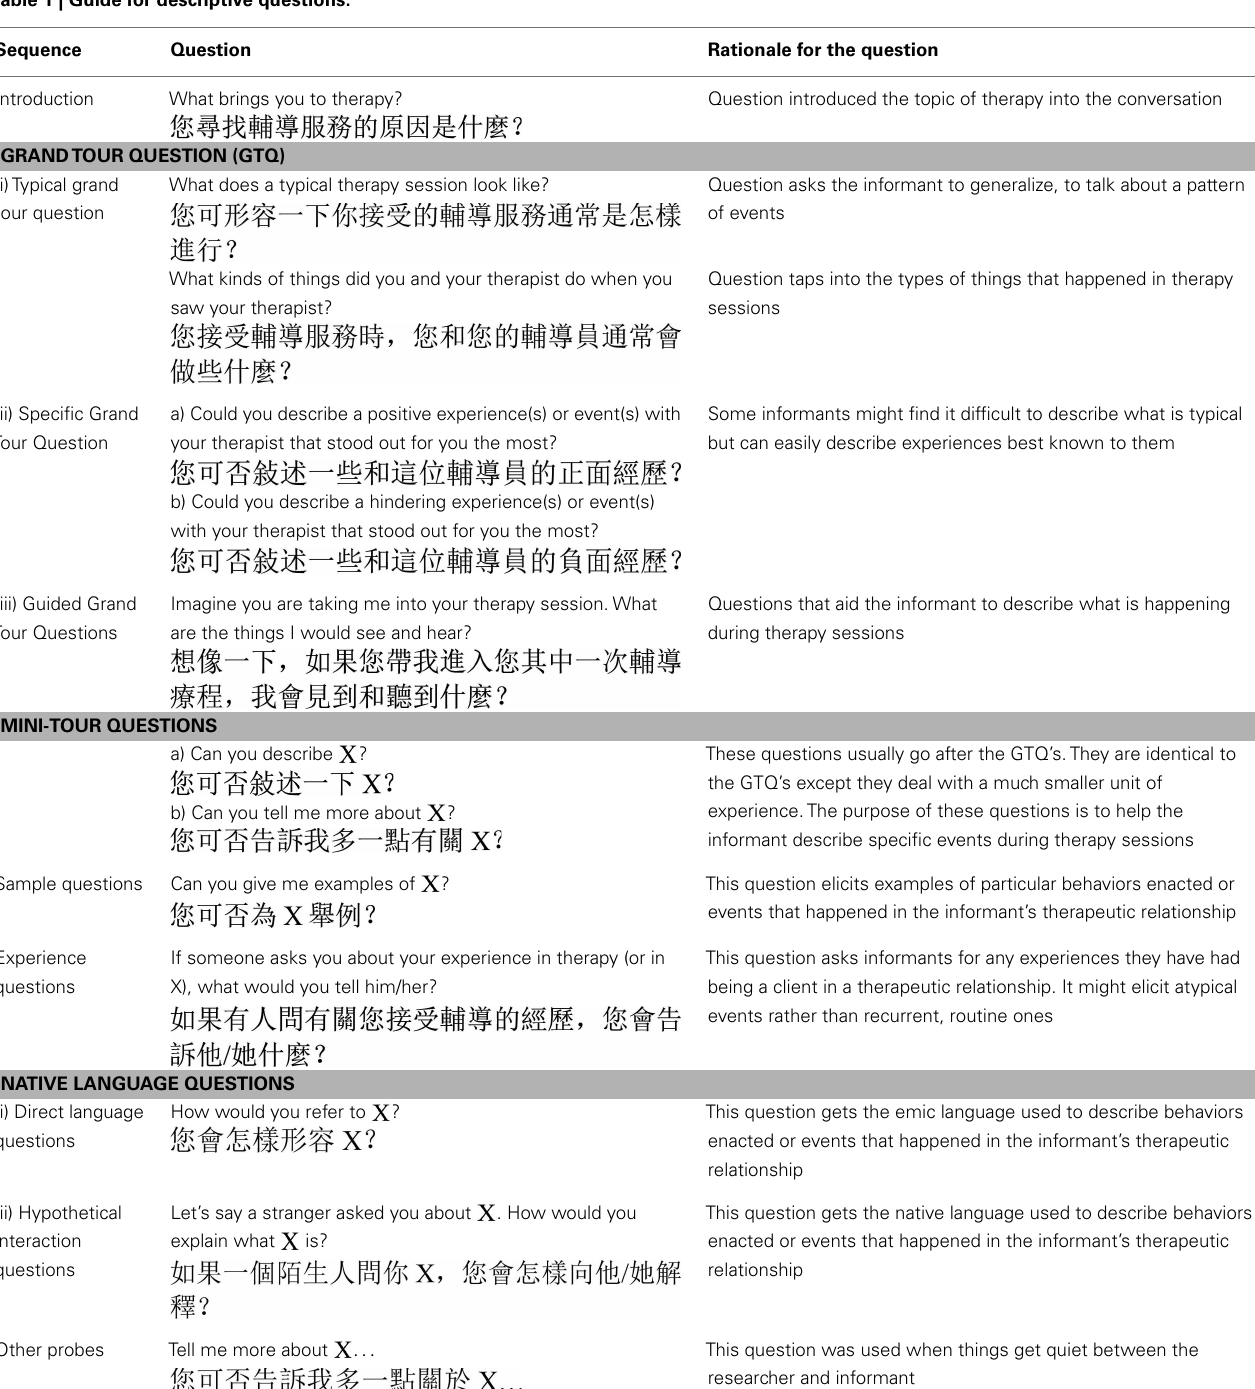
Table 1 | Guide for descriptive